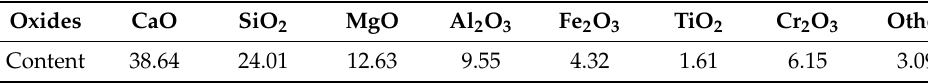
Table 1. Chemical composition of the EAF slag (wt.%).